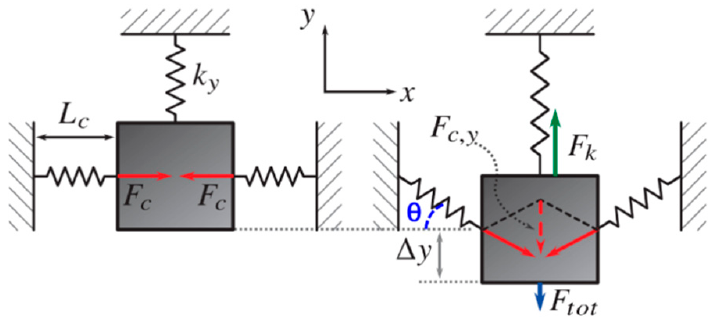
Figure 2. Conceptual illustrations of a MEMS accelerometer with GAS. Left: a proof mass in an equilibrium position is connected to a spring in the y-direction with sti ff ness k y and two springs forming the GAS in the x-direction of sti ff ness k c , producing a lateral preloading force F c as the springs with sti ff ness k c are compressed to a length L c . Right: the proof-mass in a displaced state with a displacement of ∆ y , introducing a rotation θ and a restoring force F k = − k y * ∆ y . F c,y is the sum of the parts of F c along the axis of sensitivity. F tot is partly canceled by F c,y [13,16].